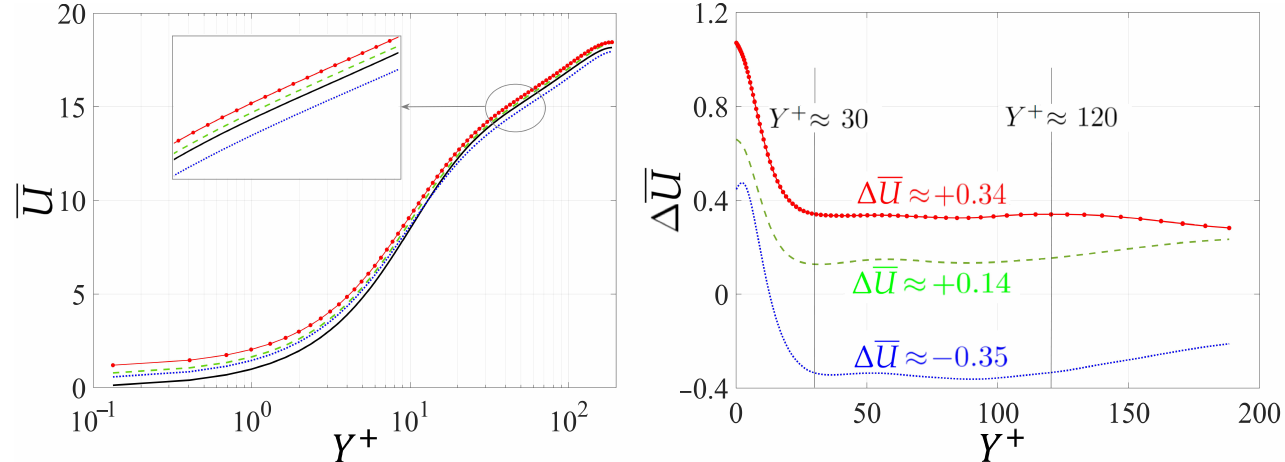
Figure 13. Mean velocity profiles next to the permeable walls: ( left ) velocity profiles in wall coordi- nates up to the centerline of the channel; ( right ) deviations of the mean velocity profiles over different substrates, from the corresponding smooth channel profile. The symbols are identical to those used in Figure